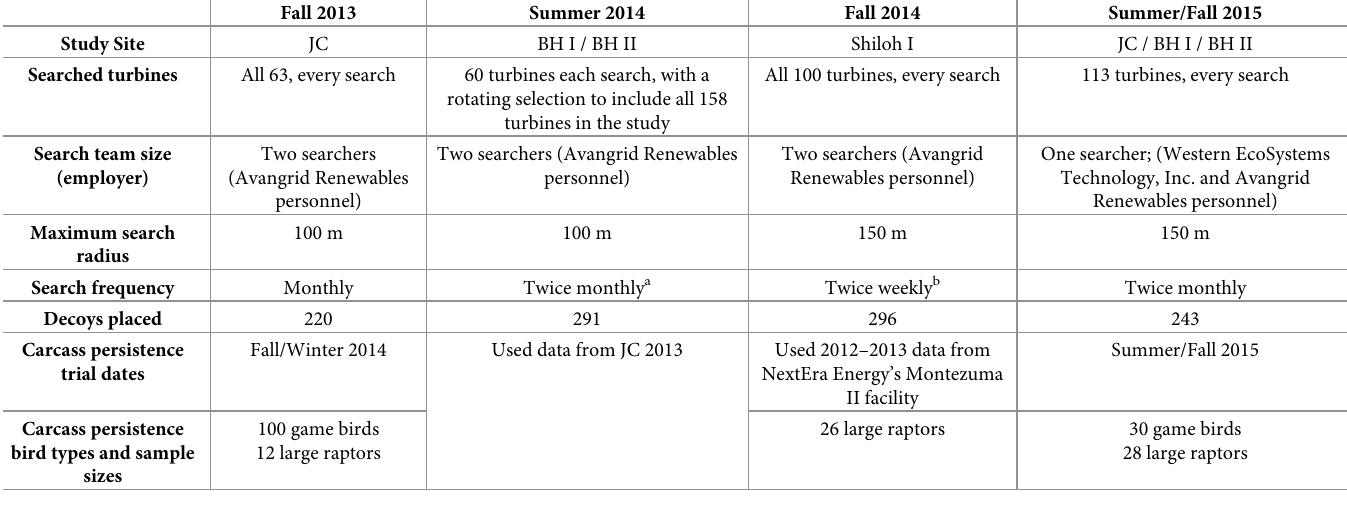
Table 1. Field method details for the four study periods. We conducted scanning searches at the Juniper Canyon (JC), Big Horn I (BH I), Big Horn II (BH II), and Shi- loh I wind energy facilities. Due to the exploratory nature of our study, we made minor protocol adjustments (e.g., expanded search radii, size of search team reduced) after encouraging results from early